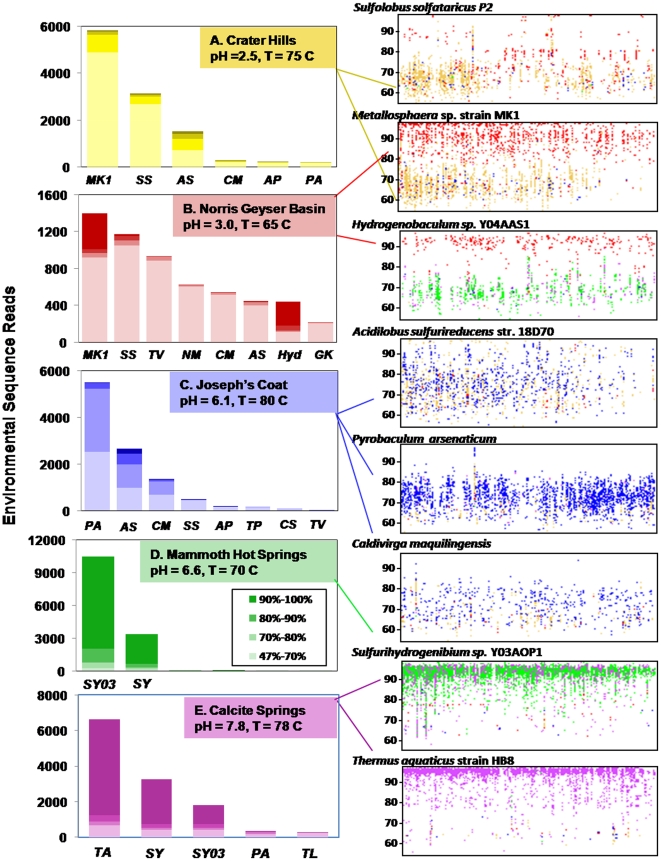
Phylogenetic analysis of metagenome sequence data.Binning of metagenome sequence reads (left column) from Crater Hills (gold), Norris Geyser Basin (red), Joseph's Coat Springs (blue), Mammoth Hot Springs (green) and Calcite Springs (violet) (with blastn similarity scores (E-values) of <10−10) to closest reference microbial genomes (abbreviations below). Environmental sequence reads were further categorized based on nucleotide identity ranging from 47–100% (shaded from light to dark, legend shown only for MHS). Fragment recruitment (right column) of metagenome sequence reads to reference microbial genomes is plotted across each reference genome (x-axis) at a nucleotide identity ranging from 50–100% (y-axis). Reference genomes: MK1 = Metallosphaera sp. str. MK1 (partial genome sequence) [19]; AS
 = Acidilobus sulfurireducens (partial genome sequence) [25]; SS
 = Sulfolobus solfataricus
[26]; CM
 = Caldivirga maquilingensis
[34]; AP
 = Aeropyrum pernix
[27]; PA
 = Pyrobaculum arsenaticum
[38]; TV
 = Thermoplasma volcanium
[31]; NM
 = Nitrosopumilus maritimus
[32]–[33]; Hyd
 = Hydrogenobaculum sp. Y04AAS1 [35]; GK
 = Geobacillus kaustophilus
[36]; TP
 = Thermofilum pendens; CS
 = Caldicellulosiruptor saccharolyticus
[37]; SY03
 = Sulfurihydrogenibium sp. Y03AOP1 [35], [39]; SY
 = Sulfurihydrogenibium yellowstonensis
[35], [39]; TA
 = Thermus aquaticus Y5.1 MC23; TL
 = Thermotoga lettingae
[40].